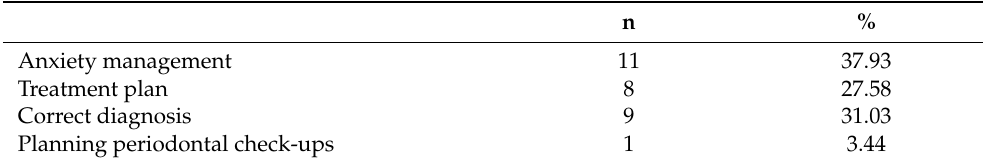
Table 6. Answers to question 4. What do you consider to be most complicated of the periodontology station with the simulated